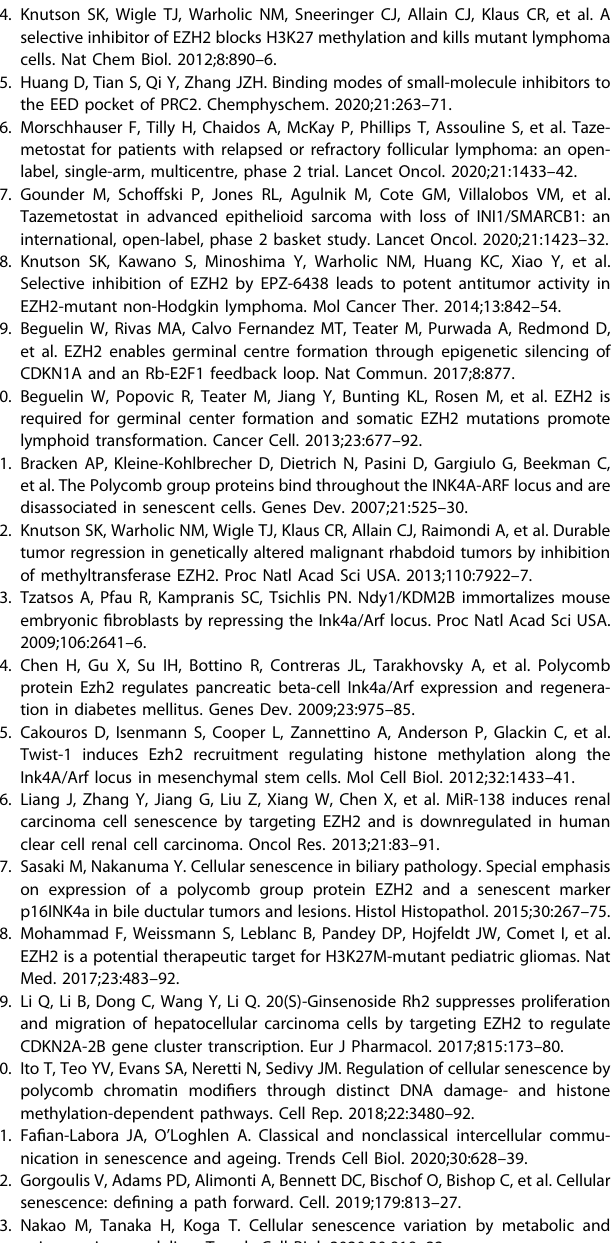
Fig. 5 PRC2 inhibition promotes tumor cell differentiation, senescence-associated in fl ammation and immune in fi ltration in vivo. GSEA of RNA-seq data from the G401 ( a ) or p16 KO ( b ) tumor xenograft collected in the study in Fig. 4E, showing the enrichment of ECM, type I IFN and antigen processing and presentation (APP) gene signatures, and cell differentiation after PRC2 inhibition. c Quantitative PCR analysis of the expression changes of IFN-I response genes in G401 or p16 KO tumor samples after vehicle or MAK683 dosing. RNA was harvested from the tumor xenograft collected from the study in Fig. 4e ( n = 6; mean ± s.d.). d Representative ITGA2 and F4/80 staining of G401 or p16 KO tumor xenograft after vehicle or MAK683 dosing collected from the study in Fig. 4E. Scale bars represent 20 μ m. Bar graphs showing the quanti fi cation of the ITGA2 positive percentage ( e ), GBP1 positive percentage ( f ) and F4/80 positive percentage ( g ). Mean ± s.d. of positively stained cell percentage or area are shown. P values were determined by Multiple t test. h Inhibition of the proliferation of G401 WT or p16 KO cells by combination of MAK683 and CDK4/6 inhibitor Palbociclib treatment. Viable cells were counted every 3 days in the presence of 50 nM of MAK683, 1 nM of Palbociclib, or combo of them, and results were normalized to DMSO samples ( n = 4; mean ± s.d.). P values were determined by Multiple t test (*, p < 0.05; **, p < 0.01; ***, p < 0.001). i Box plot of mRNA expression levels (log2 (RPM)) of EZH2 in 498 neuroblastoma samples (GSE62564). The quarter of samples with the high level of EZH2 expression (125 samples) were designated as high EZH2 group, and the quarter of samples with the low level of EZH2 expression (126 samples) were designated as low EZH2 group. j Box plots of log2 mRNA fold change (FC, calculated as shown in Supplementary Fig. 5e) between different clustering types (same gene lists of every type as in Fig. 2d) in neuroblastoma data. P values were determined by Kruskal nonparametric test. All experiments were repeated for more than two